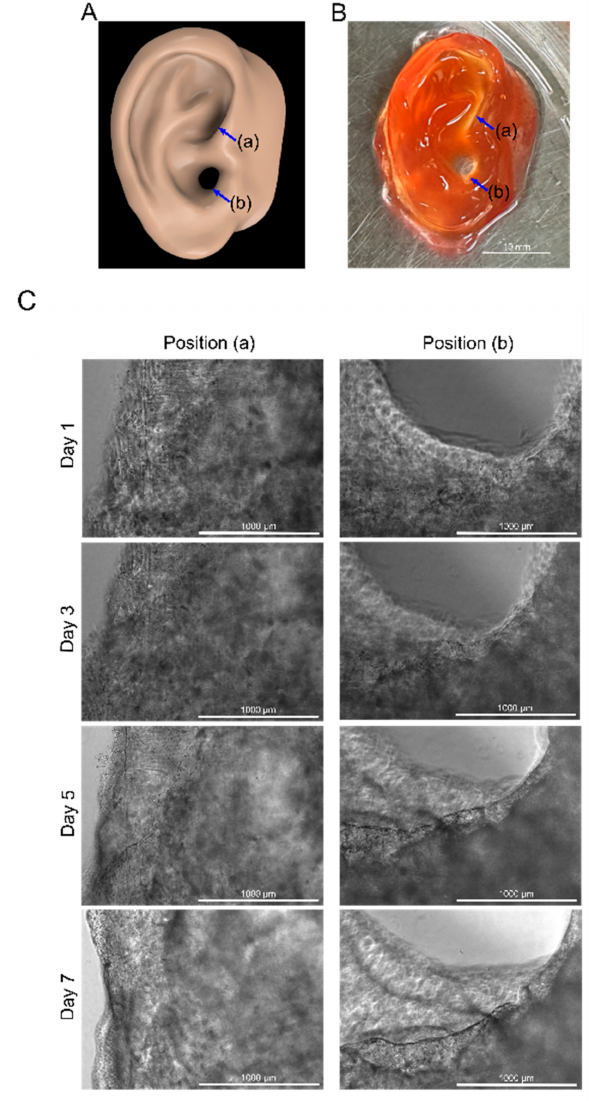
Figure 8. ( A ) 3D ear model. ( B ) Ear-shaped Z-stacked sca ff old. Scale bar = 10mm. ( C ) Phase contrast